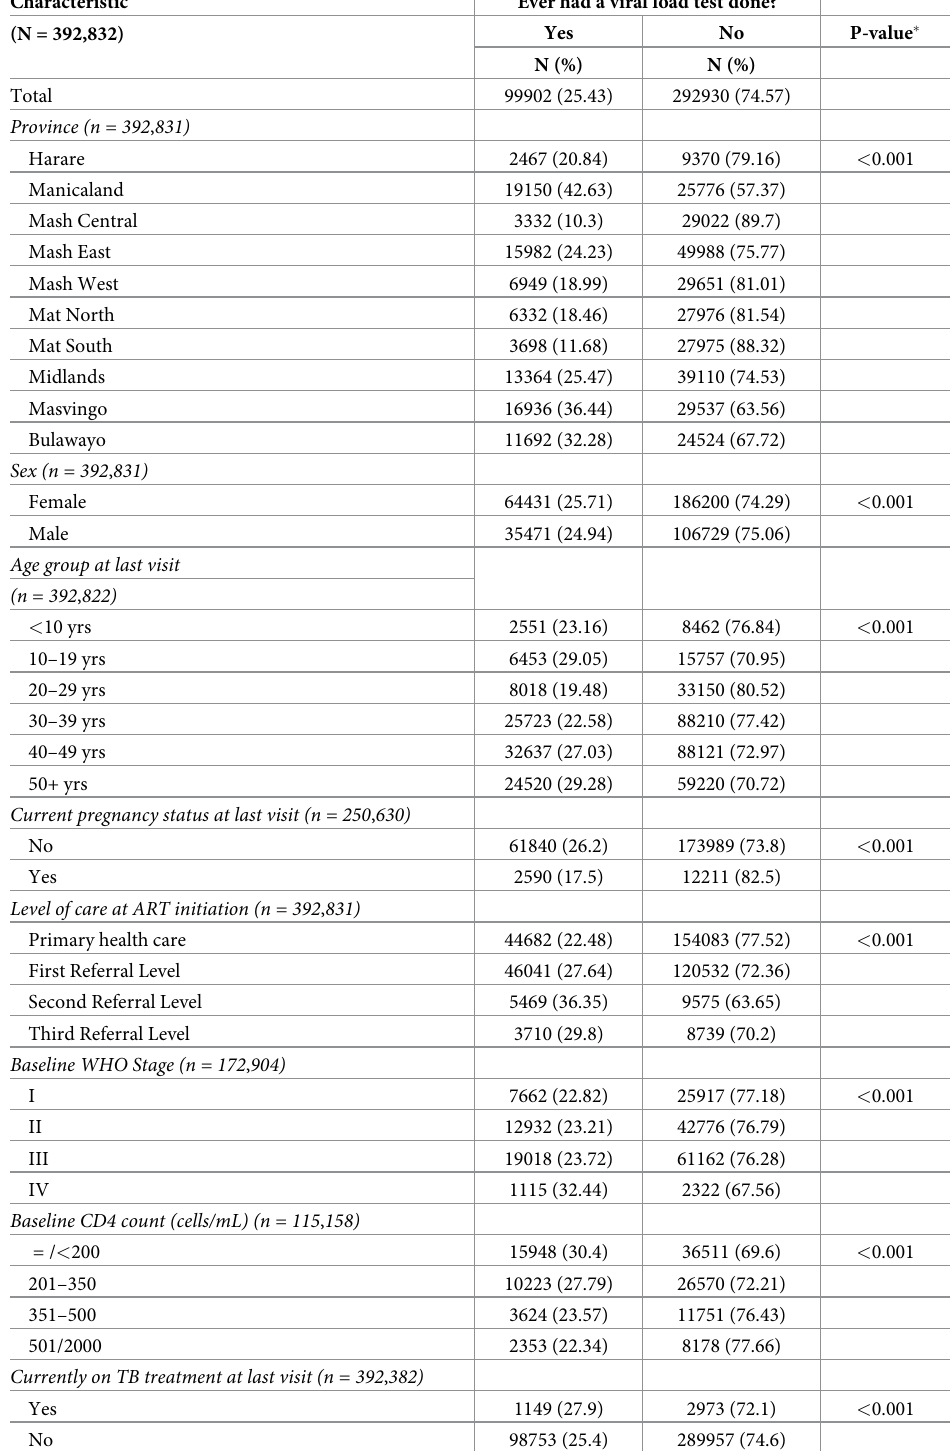
Table 1. Coverage of ever receiving viral load testing by demographic and clinical characteristics of PLHIV enrolled in the ART programme for > 12 months in health facilities using the electronic Patient Management Sys- tem between 2004 and 2017 in